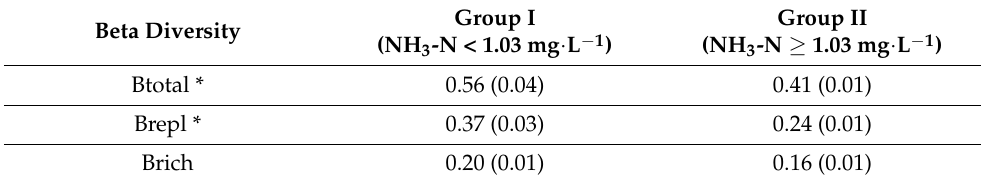
Table 2. The average and variance values of beta diversity in Group I and Group II.